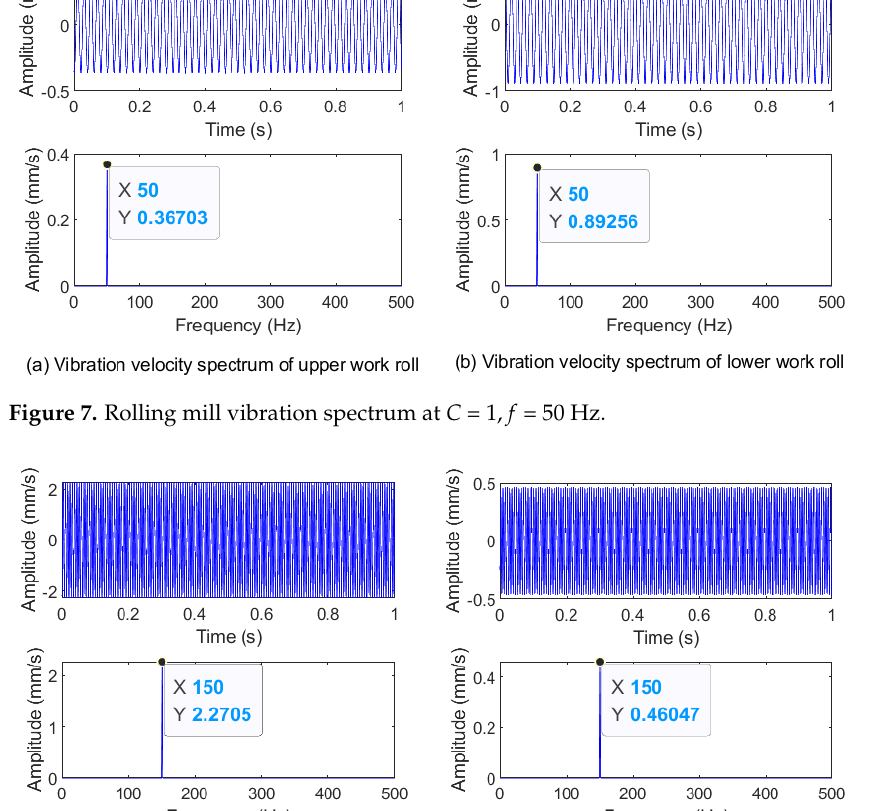
1.5 Figure 9. Amplitude frequency diagram of vibration speed of upper work roll. 00.5 1 Figure 9. Amplitude frequency diagram of vibration speed of upper work roll. 0 0.5 1